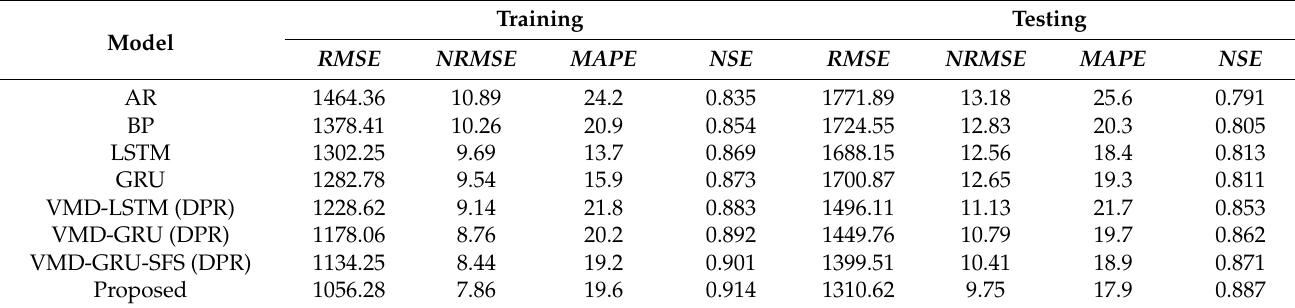
Table 3. Results of different forecasting methods for the Pingshan station.